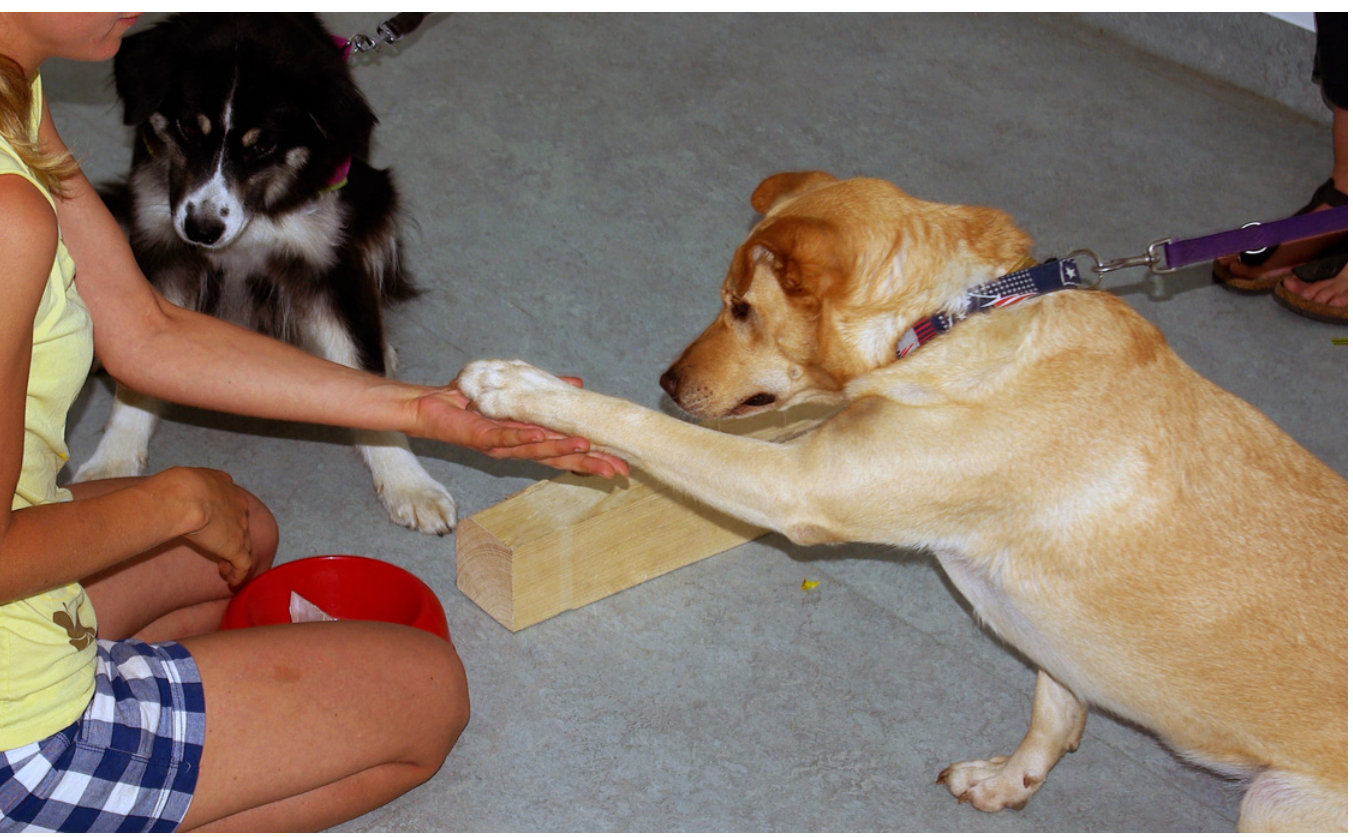
Fig 1. Setup of the paw task. The red bowl in front of the experimenter contained both reward types. The owner was standing behind the